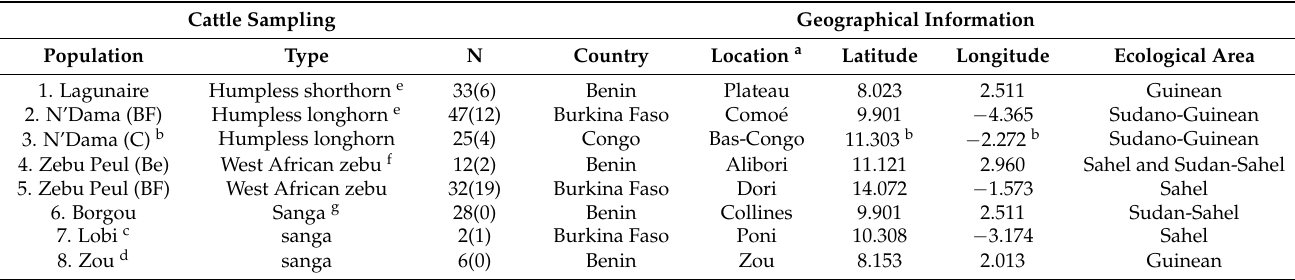
Table 1. Description of sampling. The following information is given per population sampled: type of cattle into which the population (or breed) is classified, number of samples available (N; males in brackets), country, main location, and approximate latitude and longitude (in decimal degrees) in which sampling was carried out and agro-ecological areas into which these sampling areas were classified. Numbers attached to the names of the populations are consistent with those used in Figures